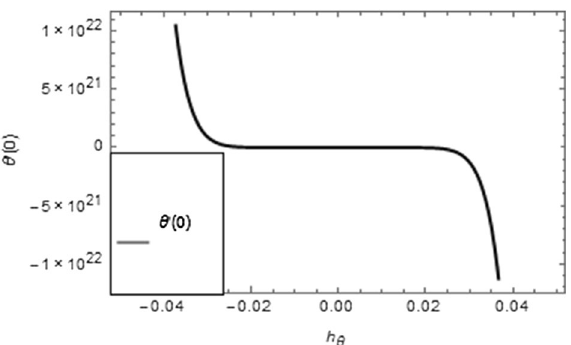
Figure 3. (cid:31) -curve for temperature